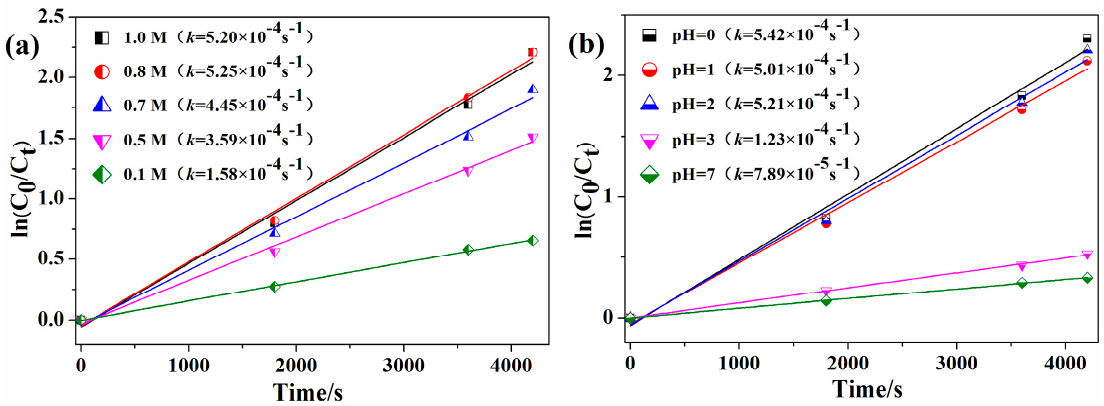
Figure 3. Plots of ln( C 0 / C t ) versus time for the MO degradation ( a ) in different sulfate concentration or ( b ) in varying pH value (pH 0, 1, 2, 3, and 7).